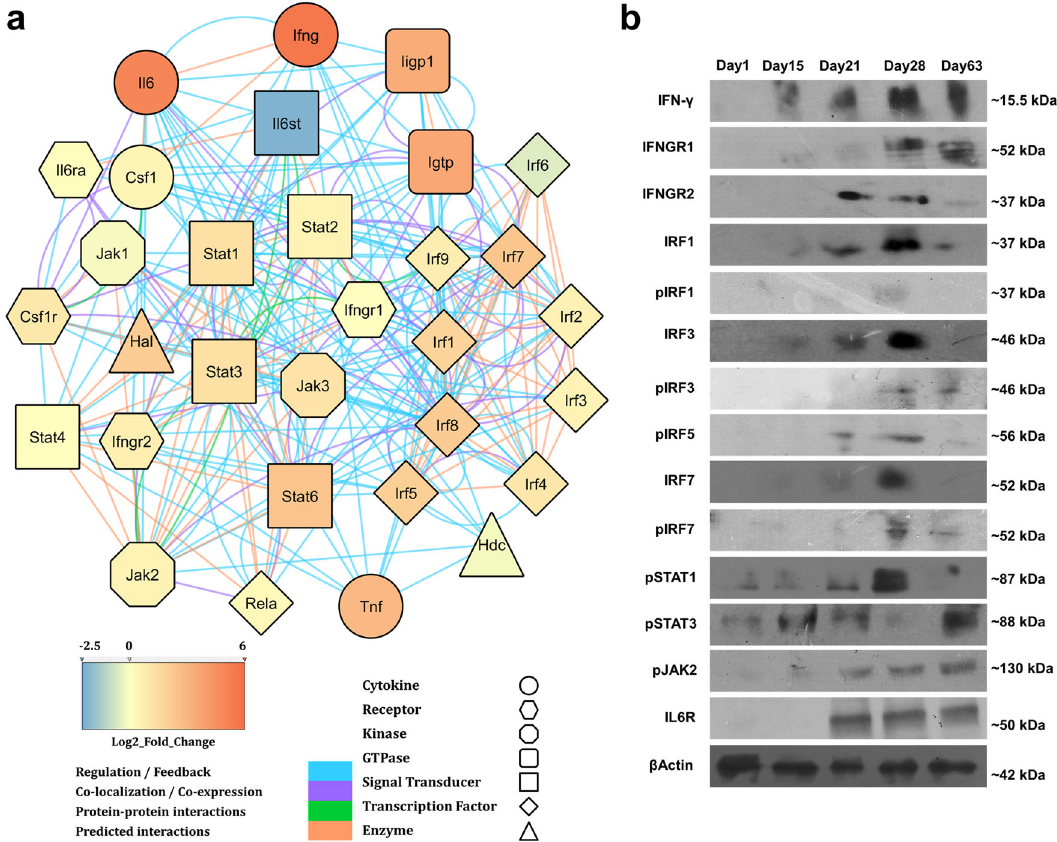
Fig. 3 An adaptive immune driven signalling network regulates the expression of host histidine sequestering enzymes. a An interaction network based on regulatory control, co-expression, co-localisation, protein – protein interactions and predicted interactions suggesting a possible regulation of HAL and HDC by IFN- γ signalling via the JAK-STAT pathway and the Interferon Regulatory Factors. (Fold changes obtained from RNAseq analysis are overlaid onto the respective molecule using the provided colour code. The nature of molecule and the nature of interaction are represented in shape and colour respectively.) b Immunoblots of mice lungs lysates reveal the expression of IFN- γ and selected downstream genes such as IRFs, JAK and STAT with disease progression. Mice β -Actin serves as the loading control (immunoblots are representative of samples obtained from nine mice for each time